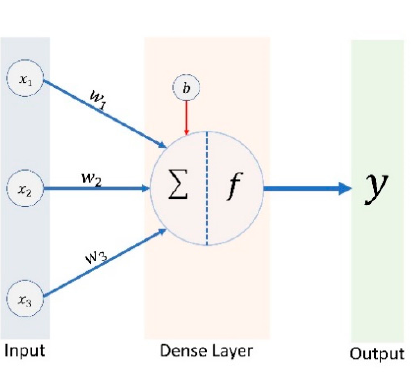
Figure 1. A simple neural network illustrating Equation (1). Inputs ( x ) multiplied by weights ( w ) are summed in the dense layer, adding bias ( b ), then the activation function ( f ) is applied to get the output. Table 1. Characteristics of the three neural network architectures used.